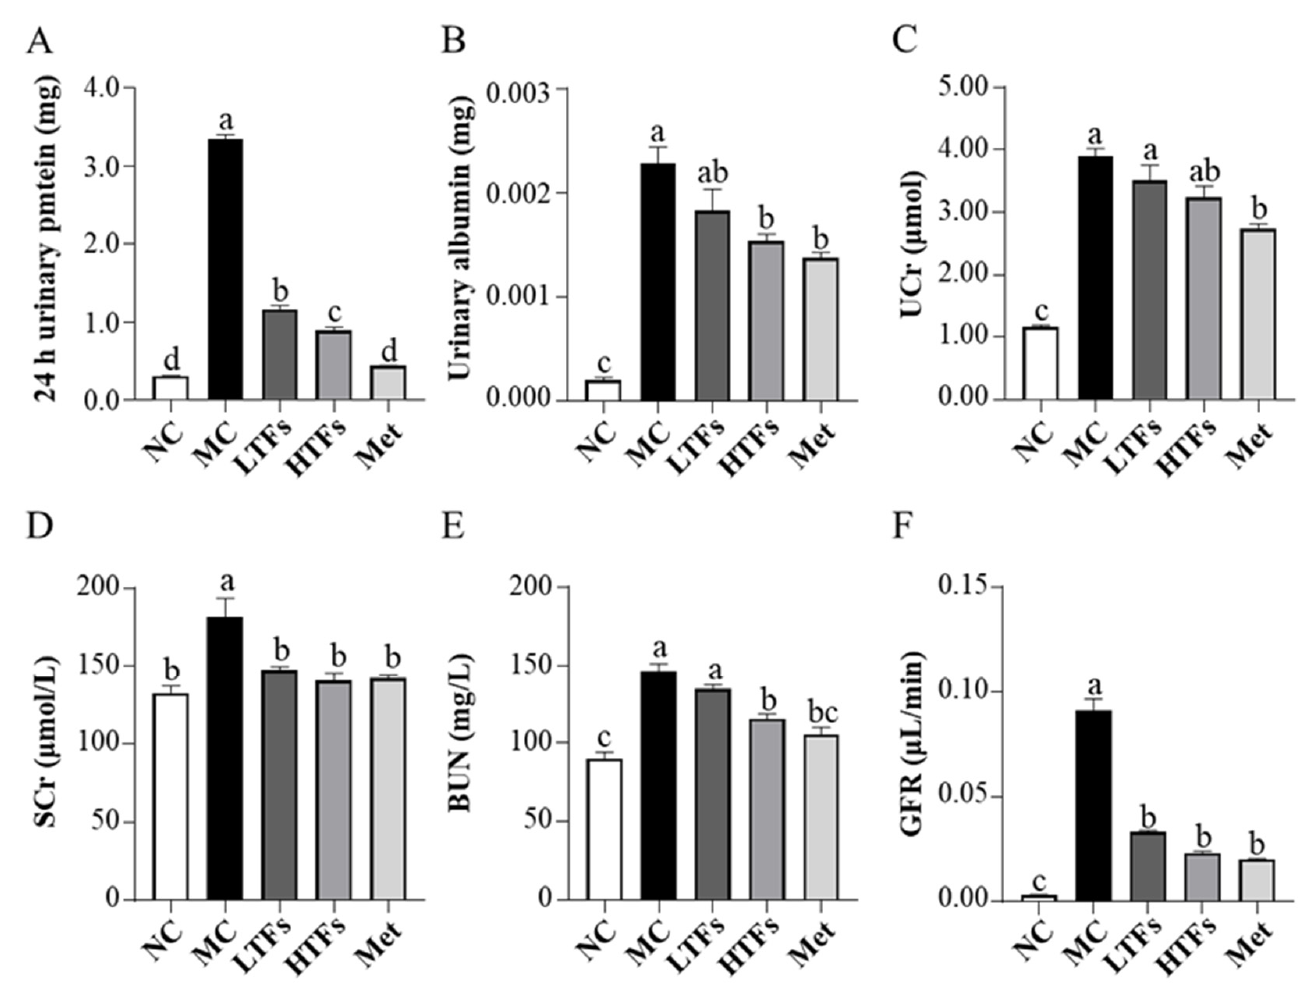
Figure 3. Effects of TFs on kidney function in T2DM mice. ( A ) 24 h urinary protein levels; ( B ) urinary albumin levels; ( C ) urine creatinine (UCr) levels; ( D ) serum creatinine (SCr) levels; ( E ) blood urea nitrogen (BUN) levels; ( F ) glomerular filtration rate (GFR) levels. NC: normal control; MC: diabetic model control; LTFs: low-dose TFs; HTFs: high-dose TFs; Met: metformin. Each value represents the mean ± SEM ( n = 6). Values with different letters (a–d) differ from each other significantly ( p < 0.05).